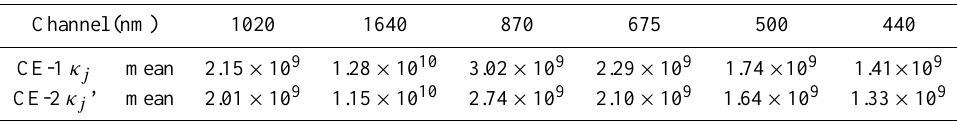
Table 3. κ j calibration constants extracted for each channel (in nm) for CE-1 and κ 0 constants for CE-2, both obtained on 9 February 2012 (W − 1 m 2 nm DC).